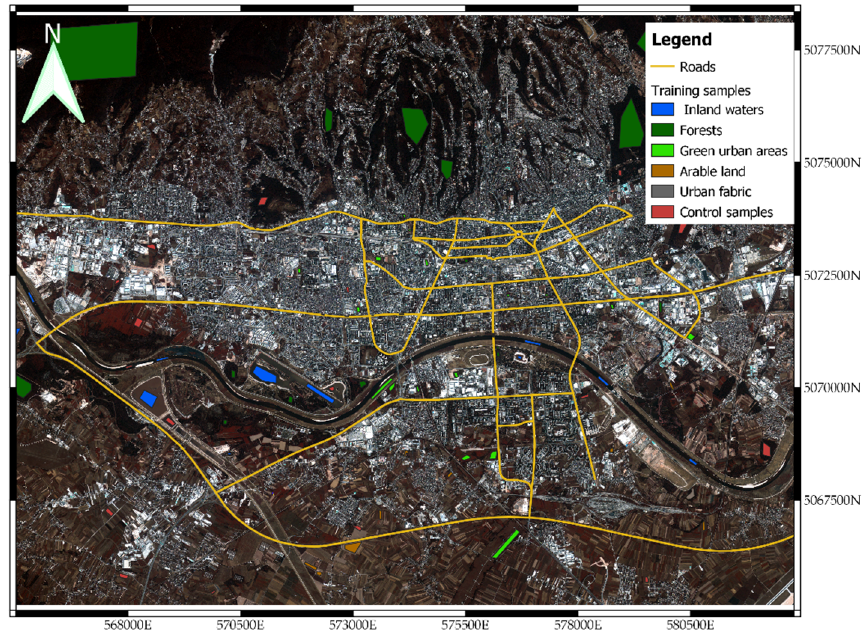
Figure 2. Roads, training and control samples [38]. Figure 2 . Roads, training and control samples [38] . Figure 2 . Roads, training and control samples [38] .